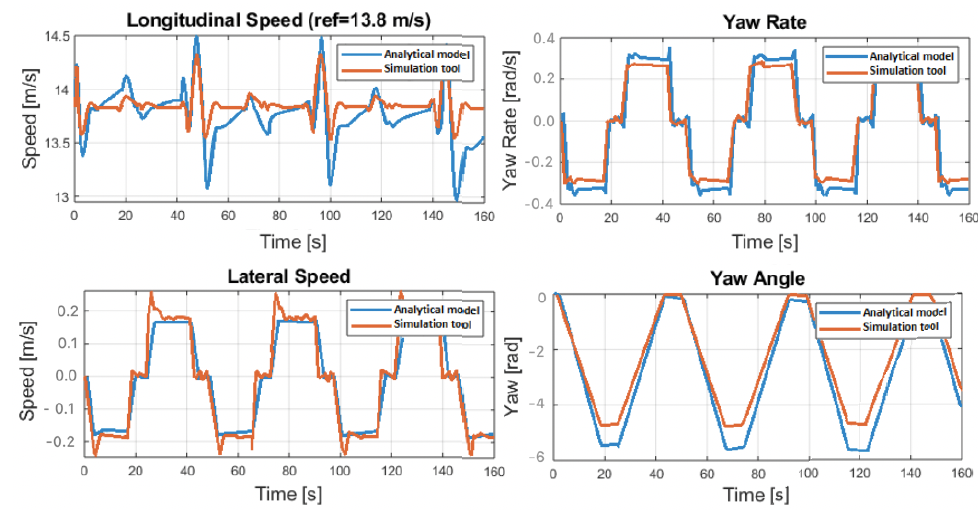
Figure 14. Static speed profile results (error percentage).